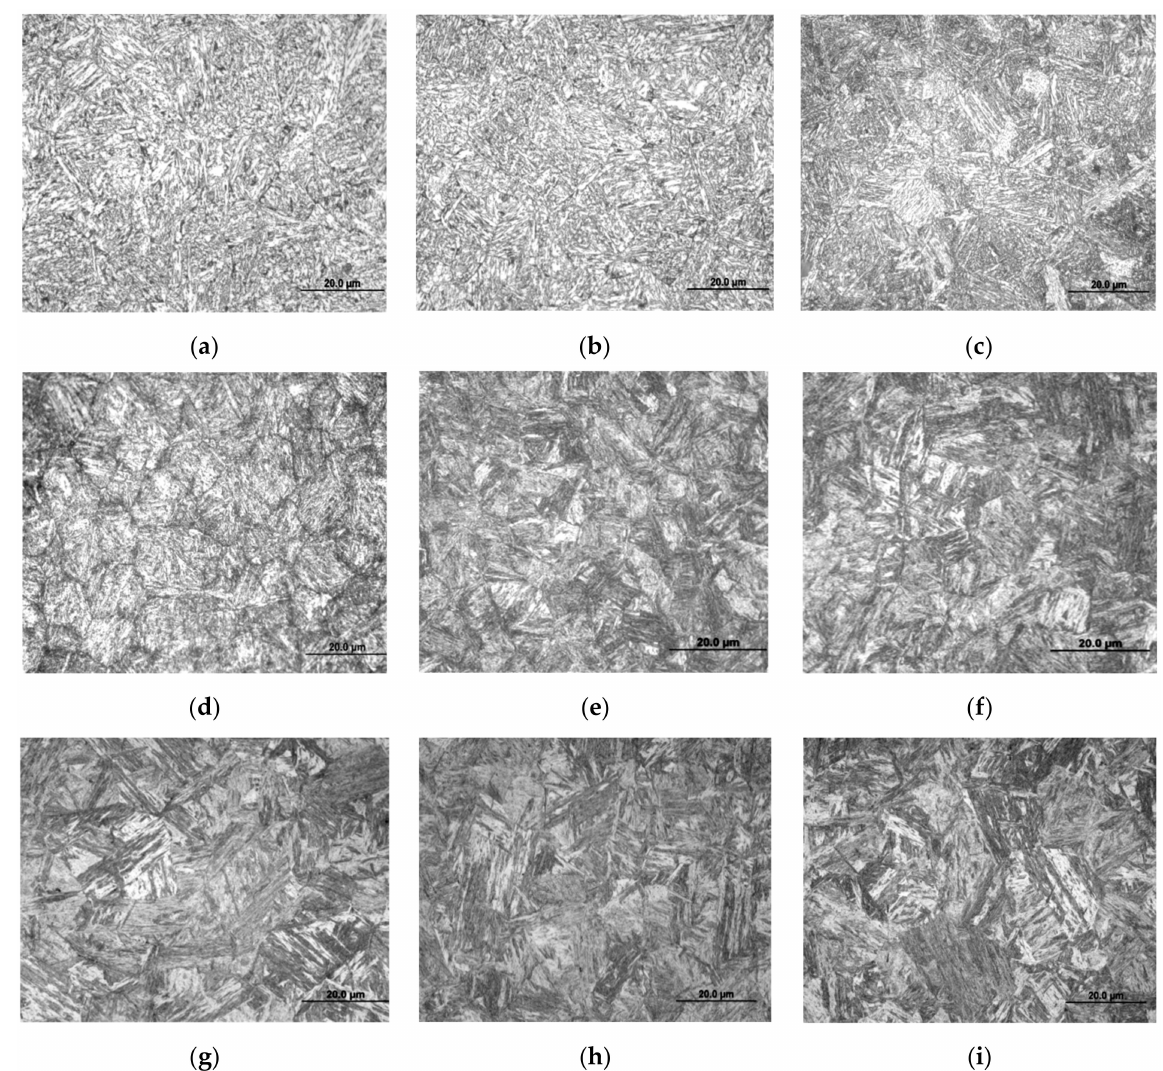
Figure 9. Microstructures of Q960E steel at different cooling rates. ( a ) 0.5 ◦ C/s, ( b ) 1 ◦ C/s, ( c ) 2 ◦ C/s, ( d ) 5 ◦ C/s, ( e ) 10 ◦ C/s, ( f ) 15 ◦ C/s, ( g ) 30 ◦ C/s, ( h ) 50 ◦ C/s, ( i ) 60 ◦